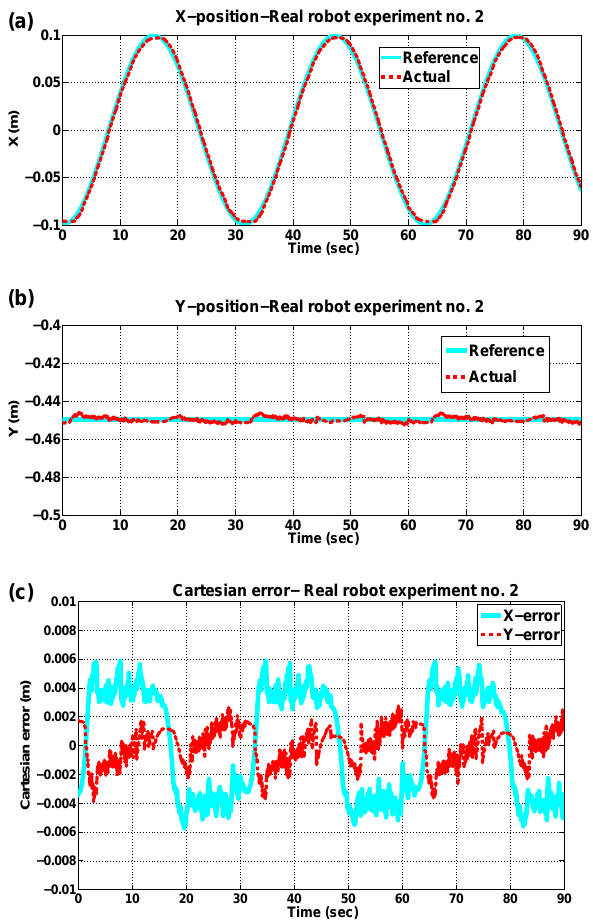
Figure 7. Cartesian position x (a) and y (b) and z (c) for K r = 8Nsm − 1 and K i = 10Nm − 1 ( Fx = Fz = 5N and Fy =